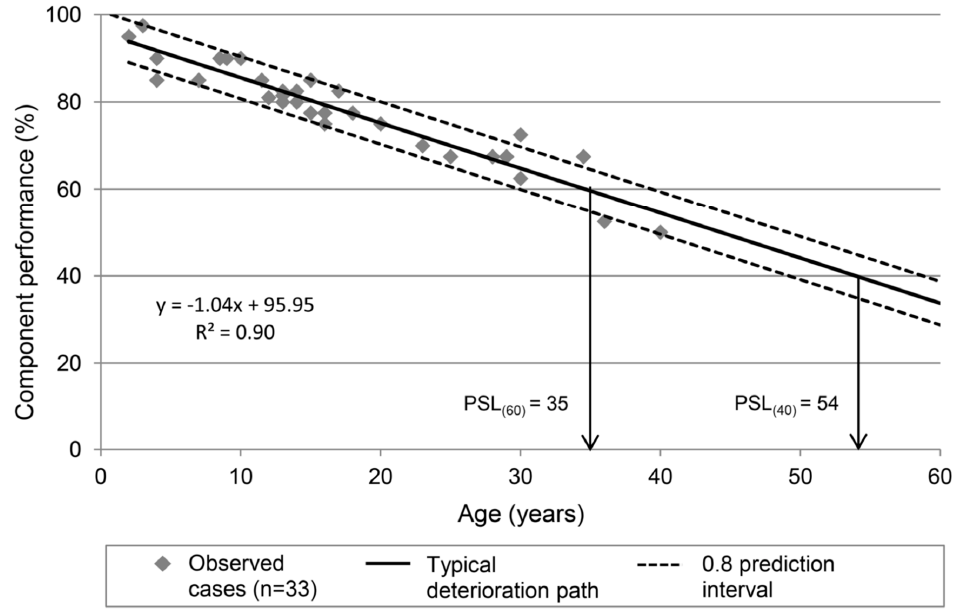
Figure 6. Deterioration pattern of wet-fixed exterior stone claddings in marine environment service conditions.